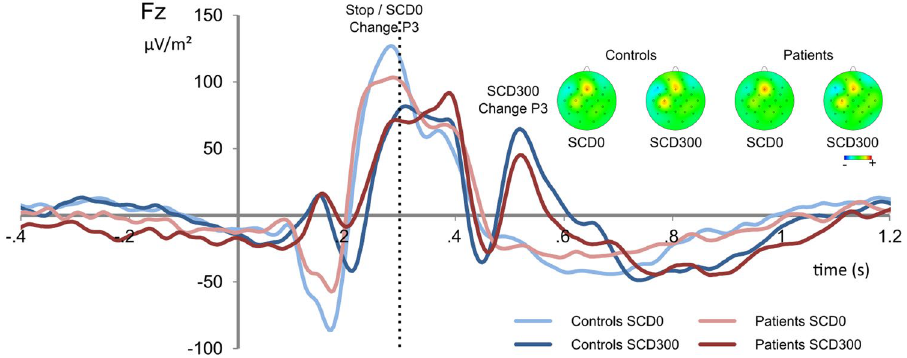
Figure 2. Event-related potential (ERP) components showing the P3 at electrode Fz. Time point zero denotes the time point of STOP stimulus delivery. Blue colors denote the control group, red colors the Tourette patient group. Lighter colors show the stop-change delay (SCD)-0 conditions, darker colors the SCD-300 condition. The scalp topography plots show the maximum amplitude of the P3 for controls and Tourette patients. Red colors show positivity, blue colors show negativity. The dashed vertical lines denote the time point of CHANGE stimulus delivery in the SCD-300